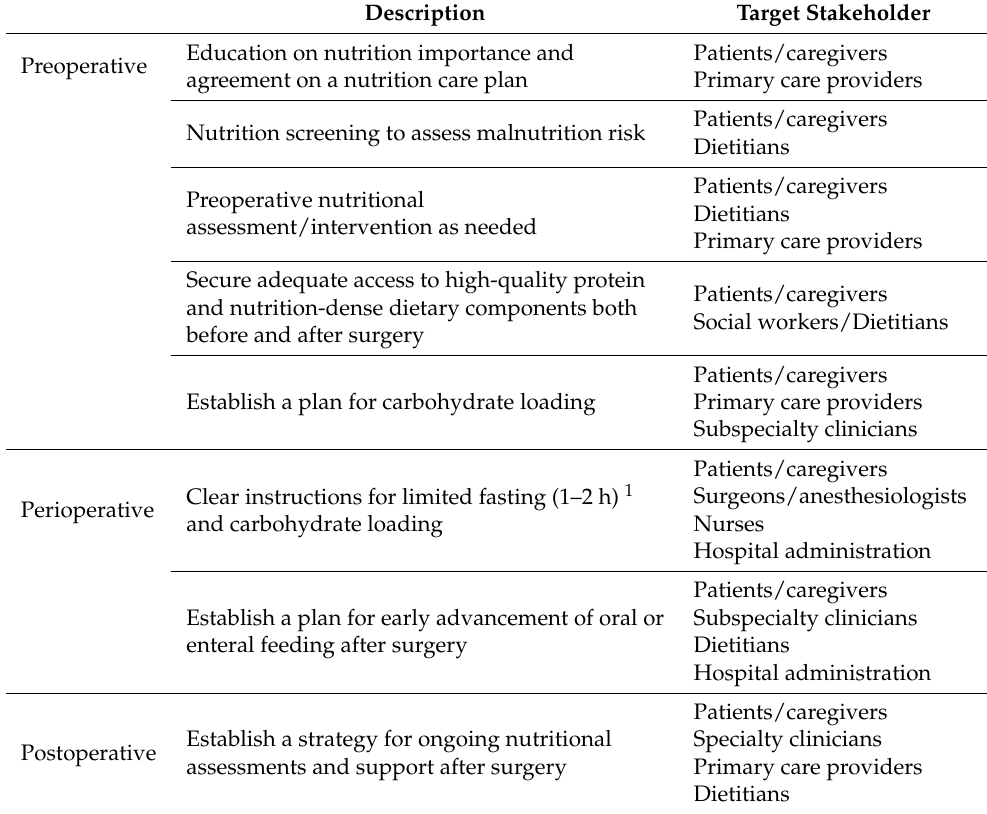
Table 2. Important Nutritional Aspects of an Enhanced Recovery